Question: In a single sentence, describe what this figure presents.
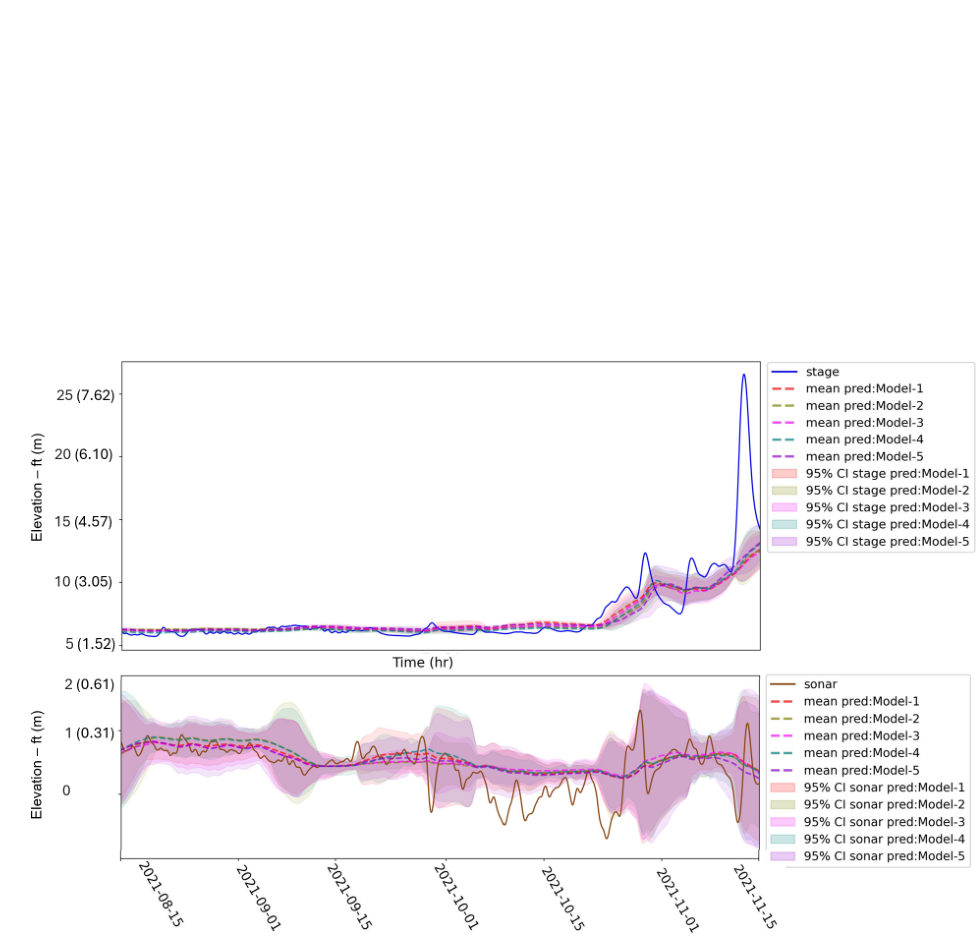
Answer: Stage (top) and Sonar (bottom) predictions of top-5 models selected by the meanMAE policy, showing mean and 95% confidence interval over the test dataset - Trask bridge.